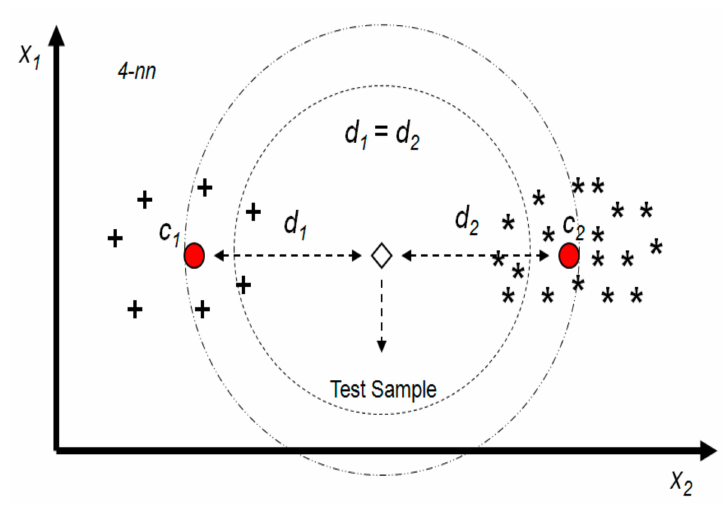
Figure 2. The e ff ect of cluster density on the KNN algorithm